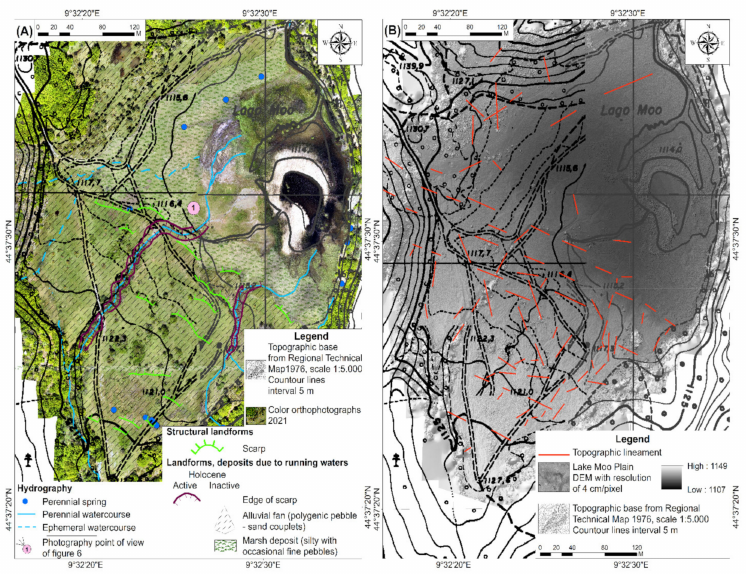
Figure 7. The main structural landforms and topographic lineament recognized in the lake Moo plain extracted from ( A ) high-resolution orthophotograph and ( B ) DEM,